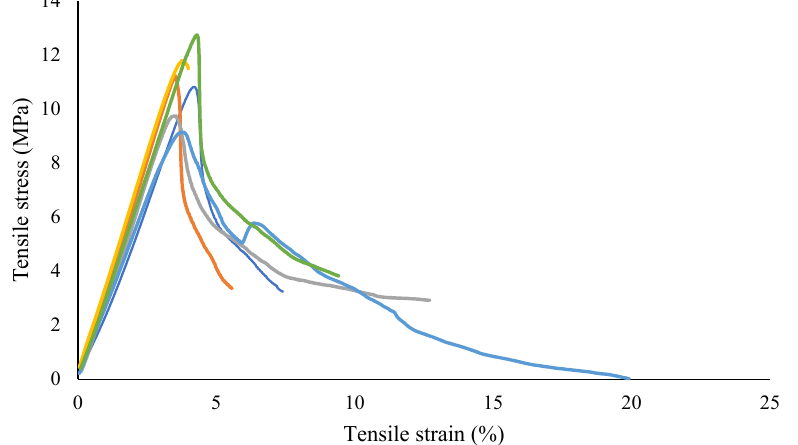
Figure 3. Tensile stress versus strain (displacement) behaviour for circular geometry samples. Table 1. Dimension (mm) and failure load of 3D printed